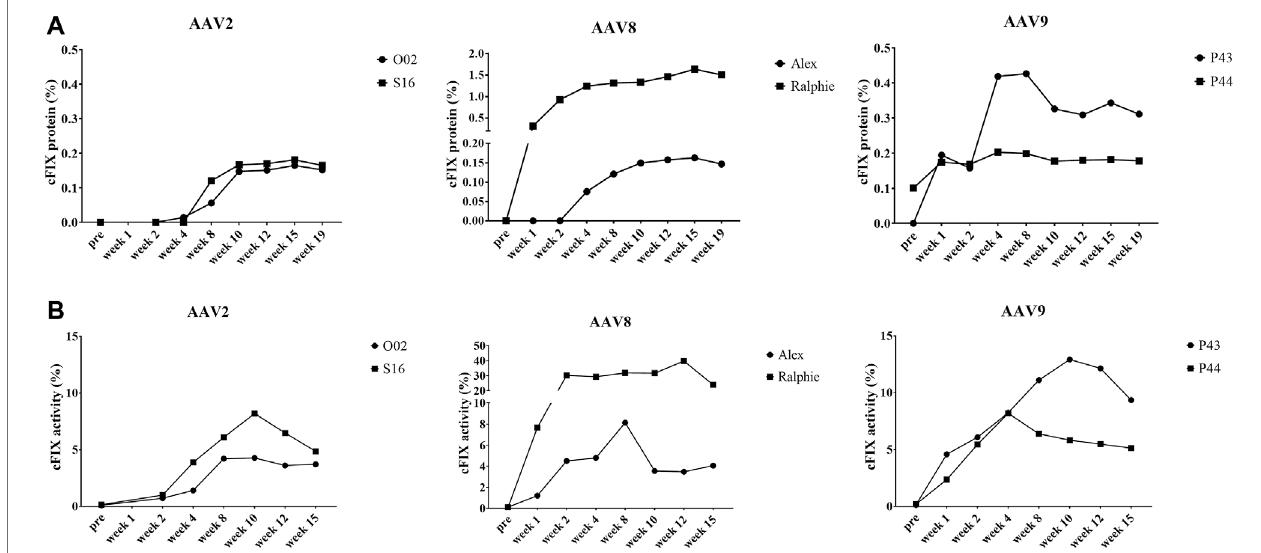
FIGURE5 | Expression and activity ofcFIX inhemophilia B dog after administration of AAV2,AAV8 or AAV9 vectors. Hemophilia Bdogs received 1× 10 12 vg/kg of AAV2, AAV8 or AAV9 packaged with a cFIX-opt-R338L transgene. Blood was collected at different timepoints. (A) canine FIX concentrations in plasmas were detected by ELISA. (B) cFIX activities were measured by aPTT assay.